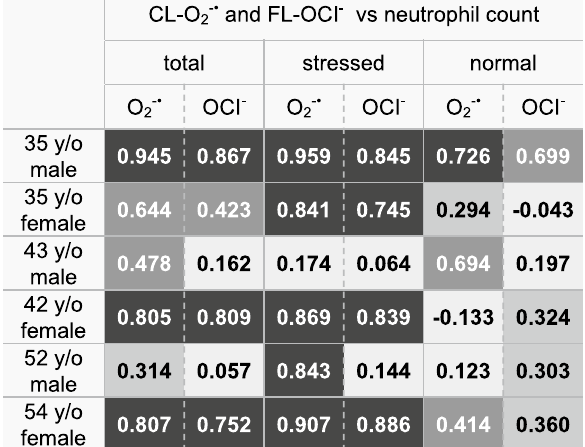
Table 3. Correlations between CL-O 2−· and the neutrophil count, and those between FL-OCl − and the neutrophil count. Left: Correlation coefficients of CL-O 2−· and FL-OCl − with the neutrophil count in the total data range. Middle: Correlation coefficients of CL-O 2 −· and FL-OCl − with the neutrophil count in the data range with stressed conditions, i.e., outside the normal/healthy range. Right: Correlation coefficients of CL-O 2 −· and FL-OCl − with the neutrophil count in the normal data